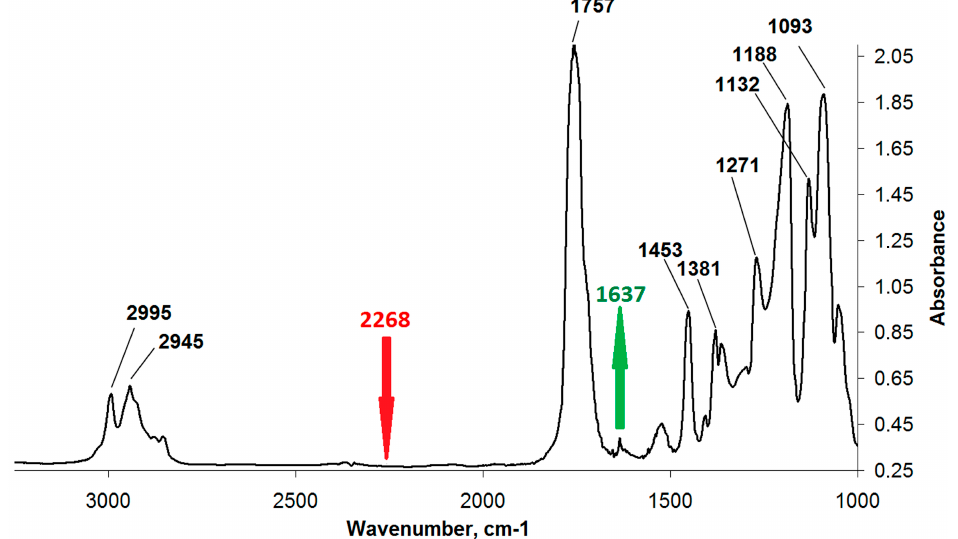
Figure 6. The structural formula of the methacrylate PLA derivative, obtained at the second stage.